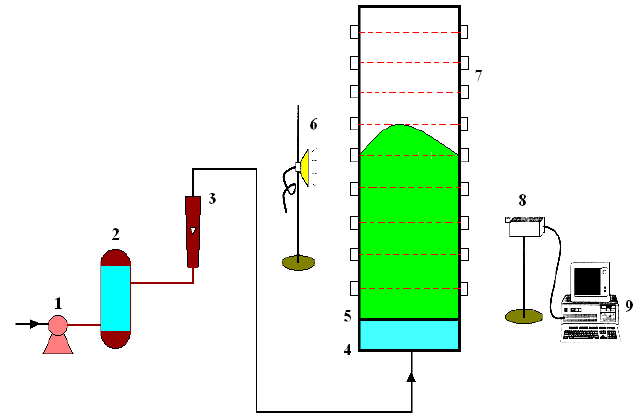
Figure 1. Schematic diagram of the experimental system. 1. Air compressor; 2. Tank; 3. Rotameter; 4.